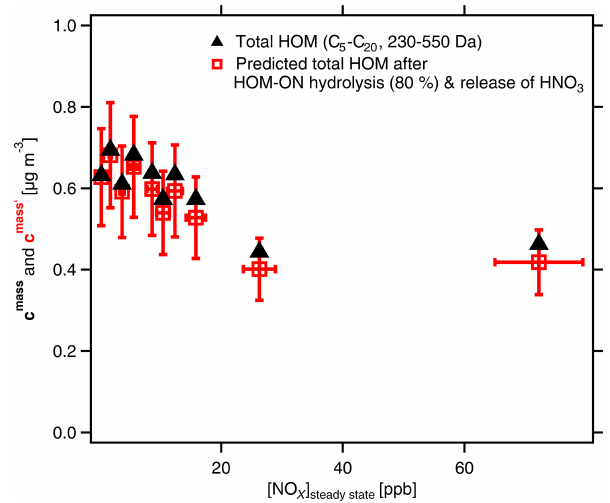
Figure 9. Mass concentrations of total HOMs (C 5 –C 20 ) with molar masses between 230 and 550Da. Black triangles show mass con- centrations c mass as determined. Red squares show c (cid:48) mass , i.e., the resulting SOA mass after considering OrgNO 3 loss by hydrolysis and evaporation of HNO 3 . [ α -pinene] SS = 0 . 9 to 2.2ppb; [NO x ] 0 up to 125ppb; [NO x ] SS = 0 . 3 to 74ppb. The effect of hydrol- ysis of 80% of the organic-bound nitrate has no substantial ef- fect on the SOA mass. Analysis is based on assigned molecular formulas ( > 90% of the total signal) applying the sensitivity of 3 . 7 × 10 10 molec.cm − 3 nc − 1 (Sect.